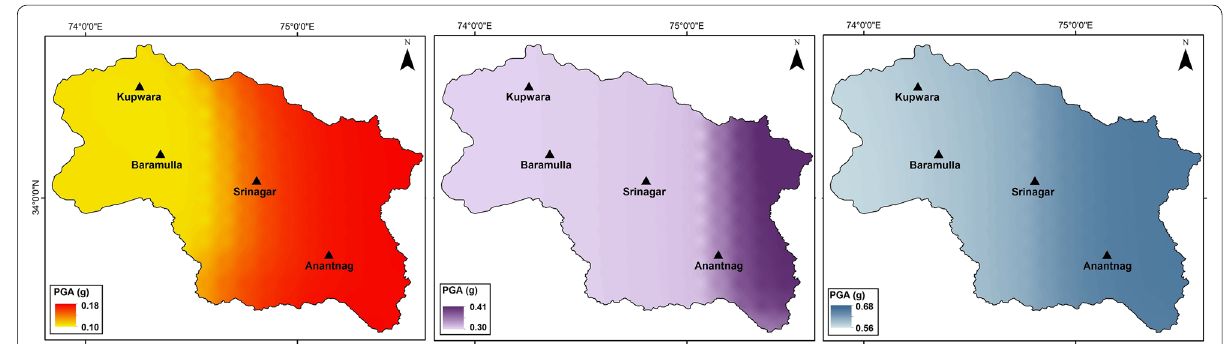
Fig. 4 The predicted peak ground acceleration (PGA) distribution estimated for hypocentral depth ranges of 0–25 km, 25–70 km and > 70 km. The computation is based on smoothly-gridded seismicity for each depth zone with a return period of 475 years